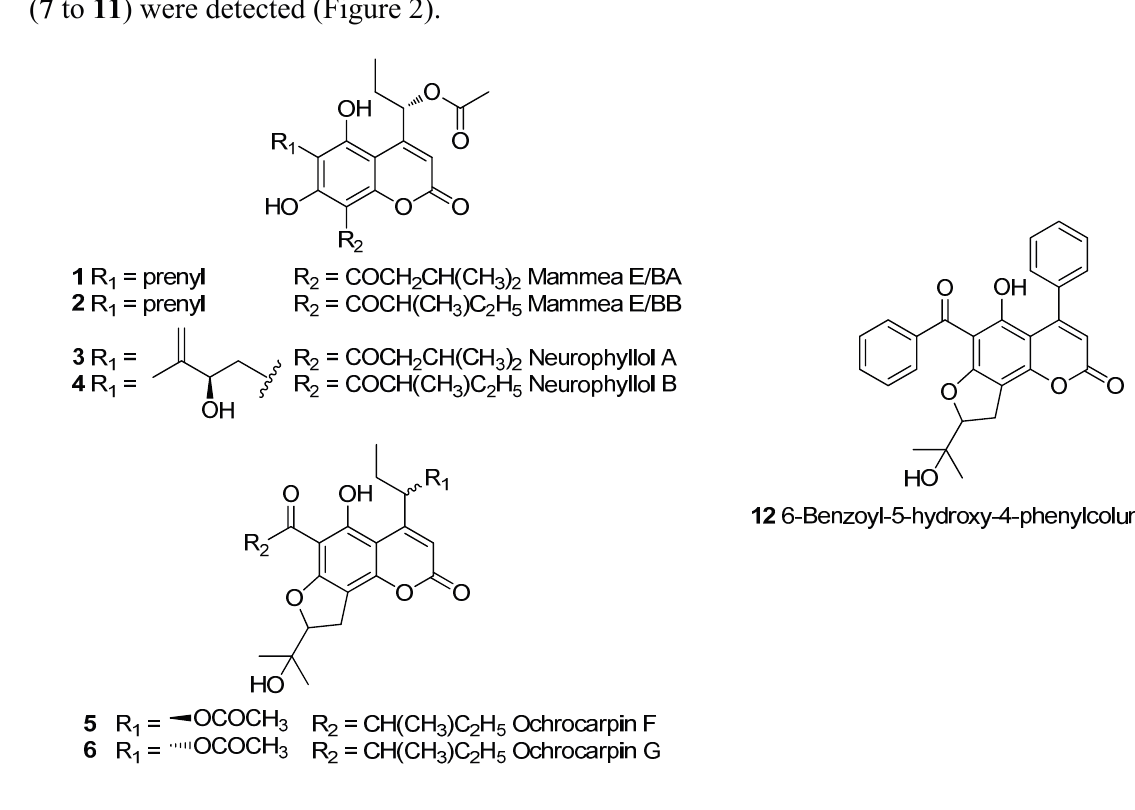
Figure 1. Structure of known coumarins 1 to 6 and 12 isolated from Mammea neurophylla